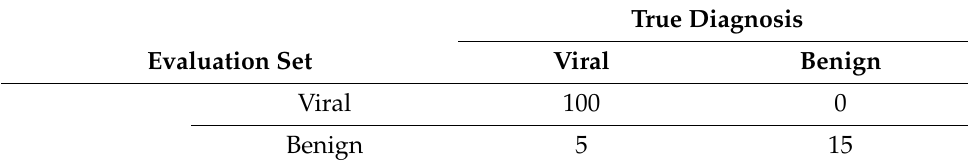
Table 19. OC-SVM model: Sink-middle. True Diagnosis Evaluation Set Viral Benign Viral 262 238 Benign 14 6